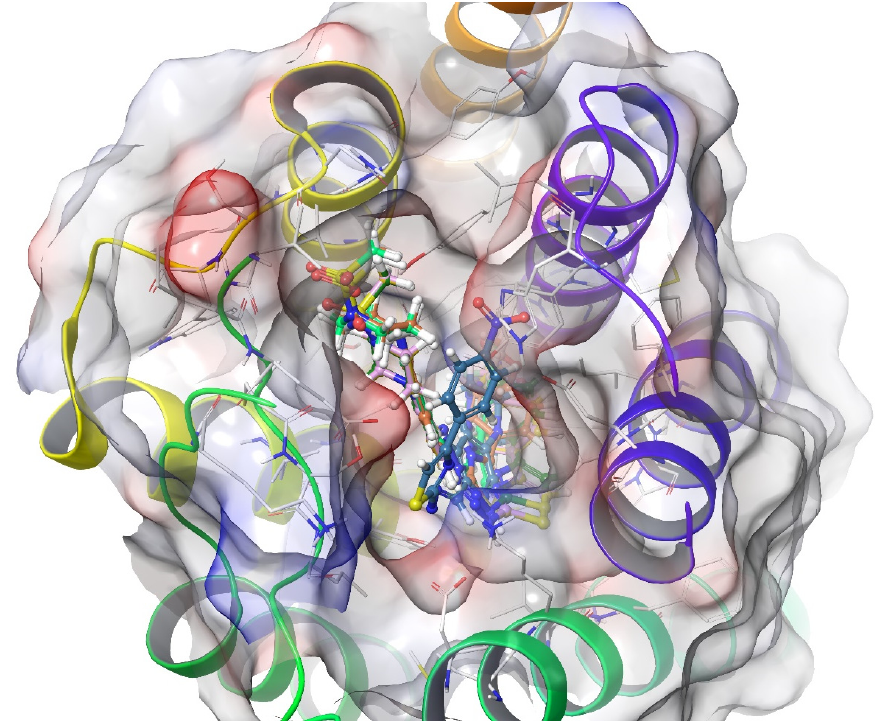
Figure 20. The three-dimensional pose of the interaction of all compounds with the ĸ -opioid receptor (PDB Code:6B73) active site. The compound 3e is presented by a tube model colored with blue.